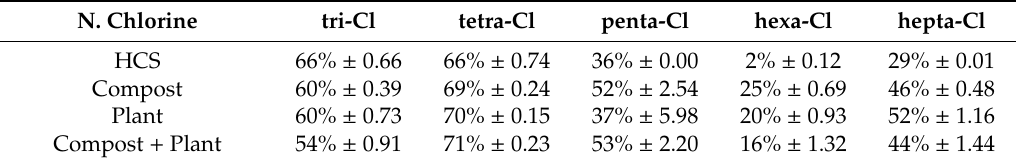
Table 3. Removal percentages of the sum of PCB congeners grouped by number of Cl atoms at day 224 in the various treatments. HCS = historically contaminated soil; Compost = historically contaminated soil treated with compost; Plant = historically contaminated soil with Alfalfa plant; Compost + Plant = historically contaminated soil treated with the compost, in the presence of Alfalfa plant. N. Chlorine tri-Cl tetra-Cl penta-Cl hexa-Cl hepta-Cl HCS 66% ± 0.66 66% ± 0.74 36% ± 0.00 2% ± 0.12 29% ± 0.01 Compost 60% ± 0.39 69% ± 0.24 52% ± 2.54 25% ± 0.69 46% ± 0.48 Plant 60% ± 0.73 70% ± 0.15 37% ± 5.98 20% ± 0.93 52% ± 1.16 Compost + Plant 54% ± 0.91 71% ± 0.23 53% ± 2.20 16% ± 1.32 44% ±